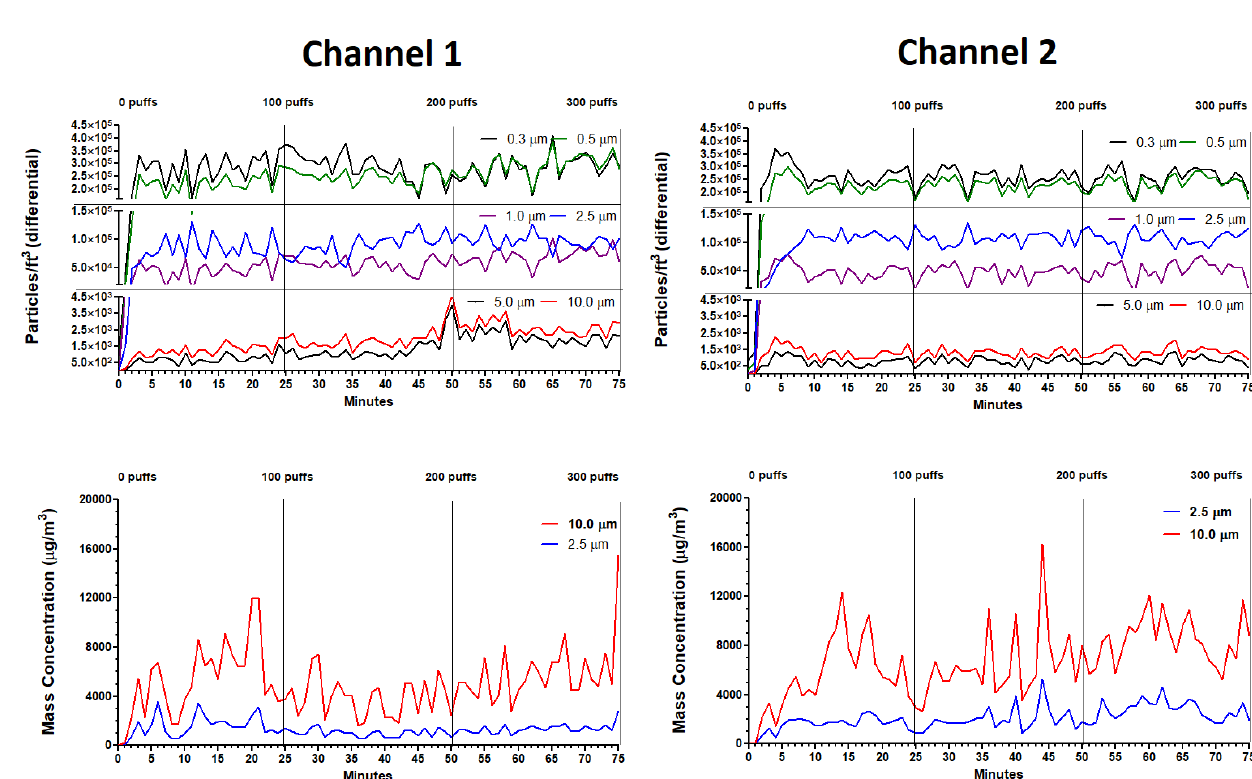
Figure 7. Particle size ( upper panels ) and mass concentration profiles ( lower panels ) during 300 continuous puffs of the ECIG aerosol generator running both channels simultaneously. Table 5. Volume of E-liquid Aerosolized per Puff of the ECIG Aerosol Generator. Channel 1 Channel 2 Combined